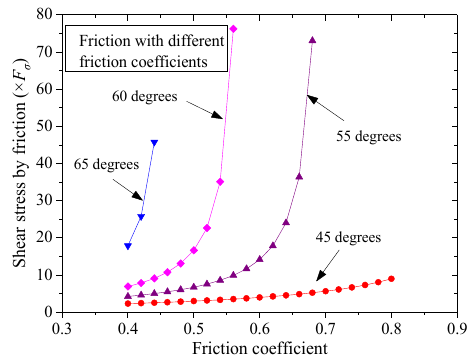
Figure 14. Friction with different friction coefficients.